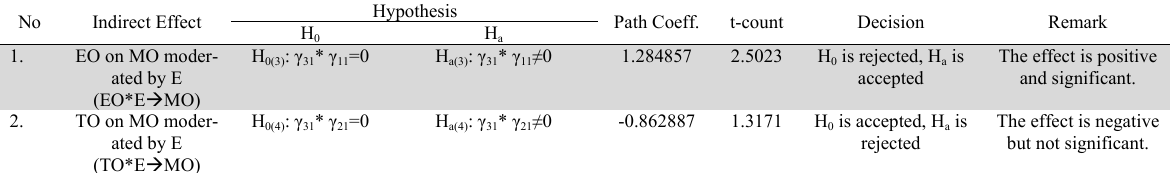
Recapitulation of t-count results from moderation effect